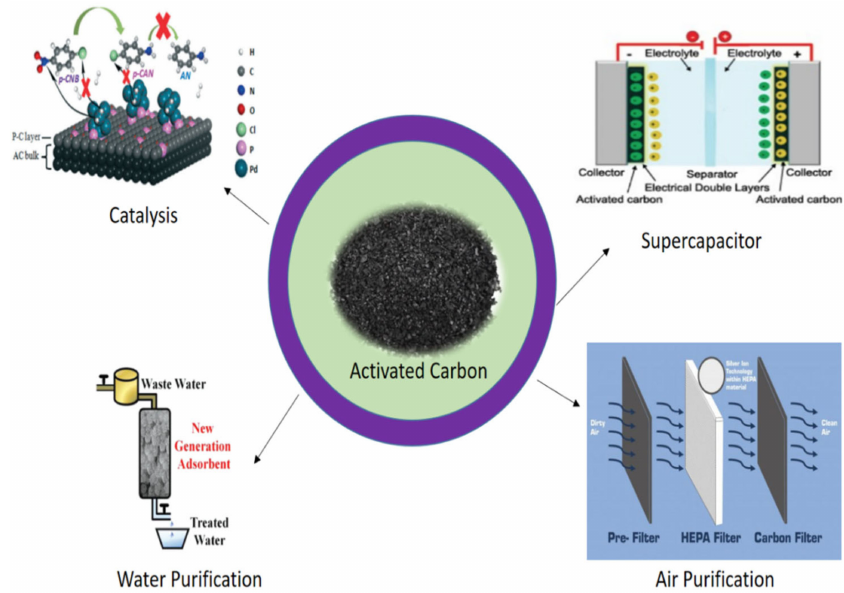
Figure 1. Use of activated carbon in various